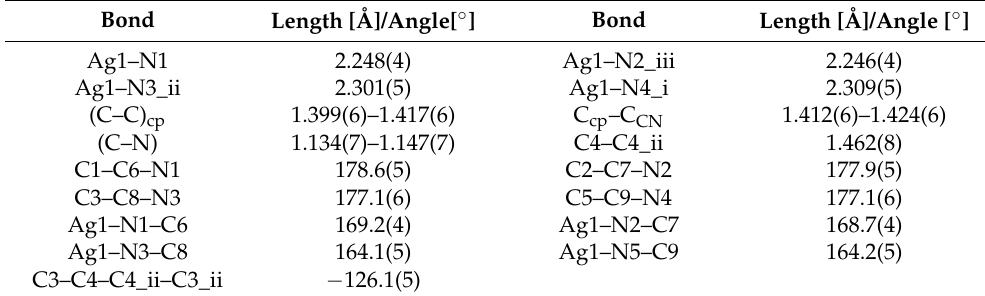
Table 2. Important bond parameters of compound 4 (low-temperature determination).